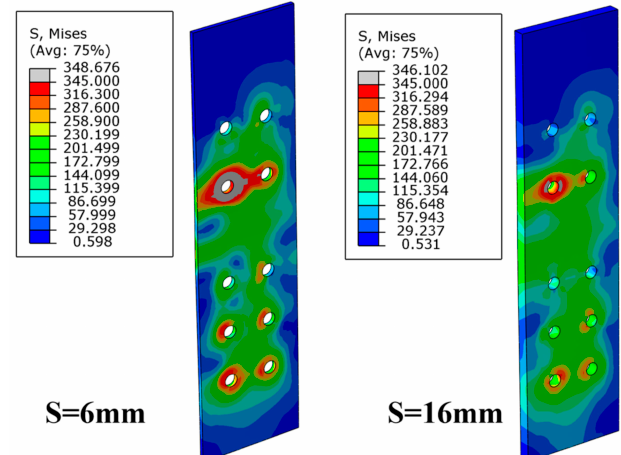
Figure 11. Stress distribution of side plates.